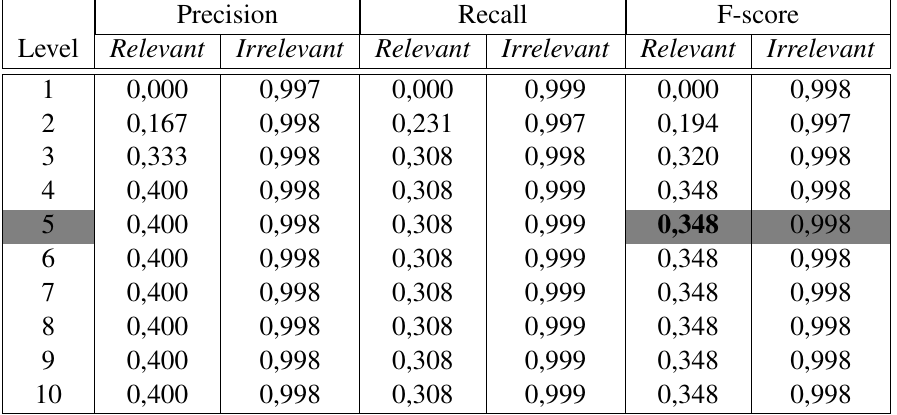
Table 5: Results achieved by the BN classifier for each MeSH level in the category